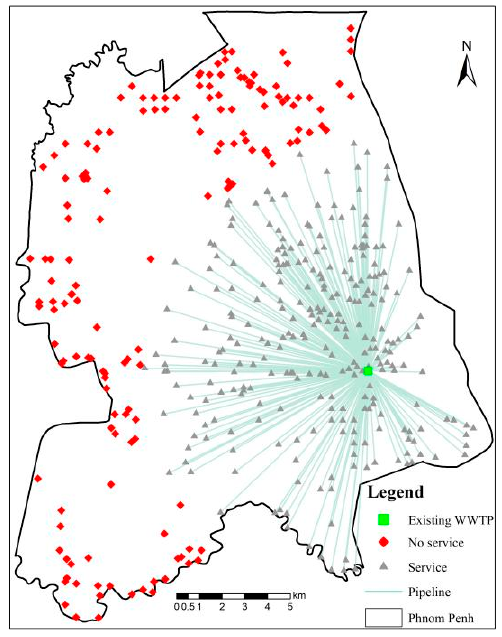
Figure 11. Current service status.